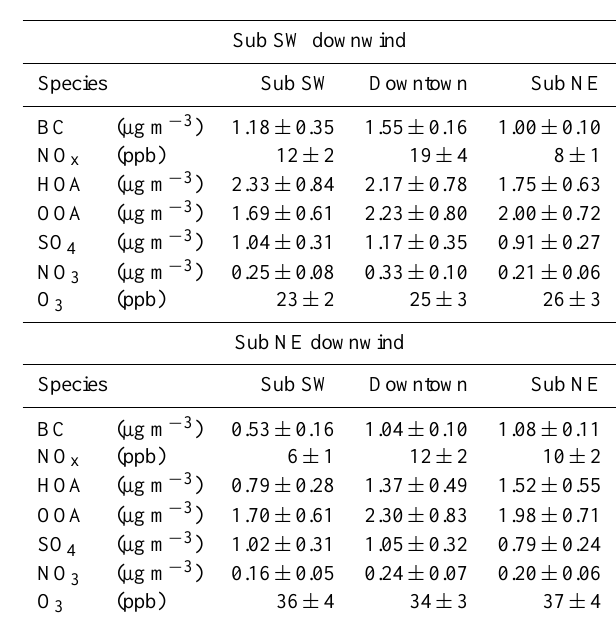
Table 5. Averages of selected species measured at the stationary sites from quasi-Lagrangian measurements at connected flow con- ditions during “Atlantic Polluted” air masses with Sub SW and Sub NE being downwind of the city centre,